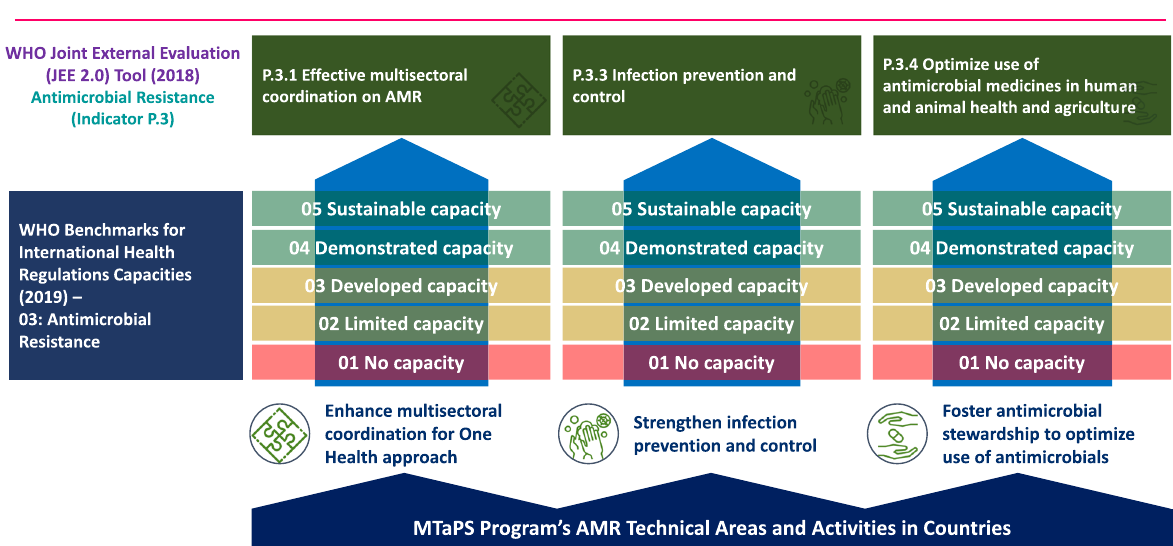
Fig. 1 Program’s GHSA-supported technical approach to align with national and global goals for AMR